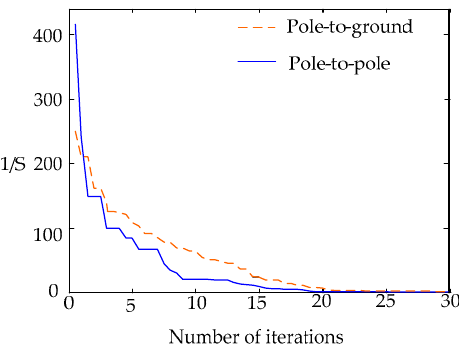
Figure 18. The relationship between the value of 1/S and the number of iterations.